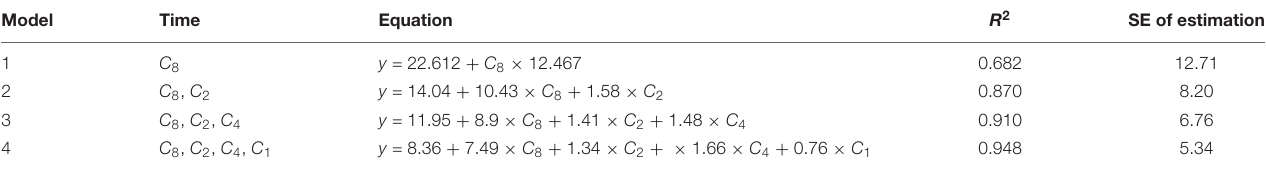
TABLE 4 | Multiple linear regression analysis of the AUC 0 − 12 h